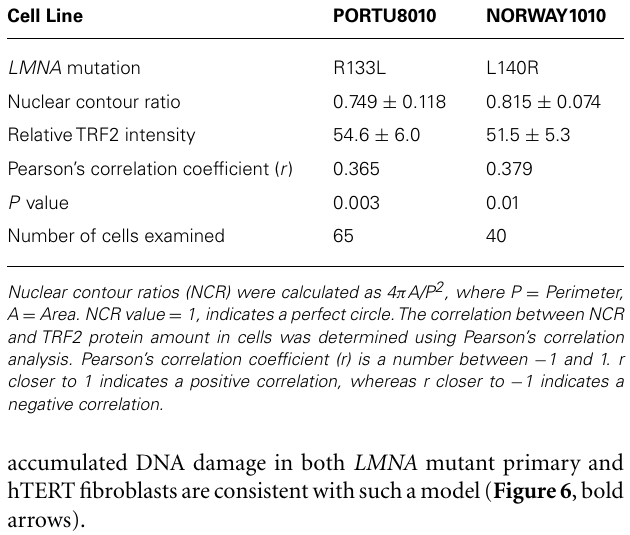
FIGURE 3 | Detection of γ -H2AX DNA damage foci in LMNA mutant cells. (A) Immuno-FISH staining of telomeres (using a telomeric PNA probe; red), γ -H2AX (green), and DNA (using DAPI; blue) in control, LMNA mutant and WRN mutant cells.White boxes in the merged images indicate areas that are enlarged 5 × and shown to the bottom. Scale bar: 2 μ m. (B) Percentages of